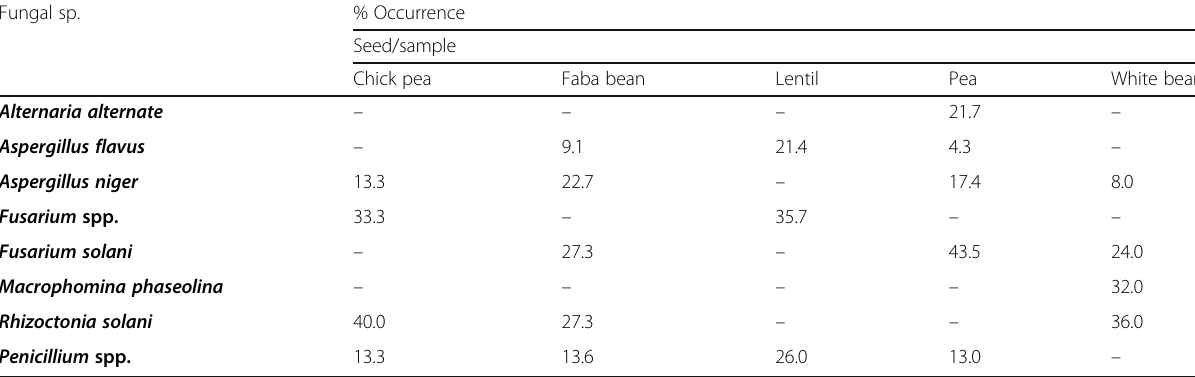
Table 1 Frequency of seed borne fungi recorded from five different legume seeds Fungal